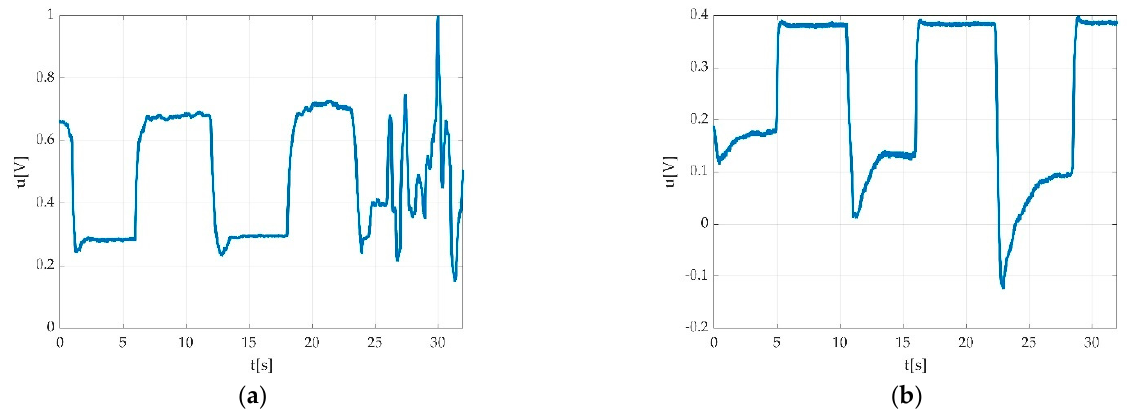
Figure 15. Improper recording due to participant indiscipline: ( a ) participant moved/shifted the trunk during plantar flexion measurement, altering the measurement-resulted signal; ( b ) participant shifted the trunk backwards while tensioning the strap during dorsiflexion, resulting in a sudden increment of voltage value.